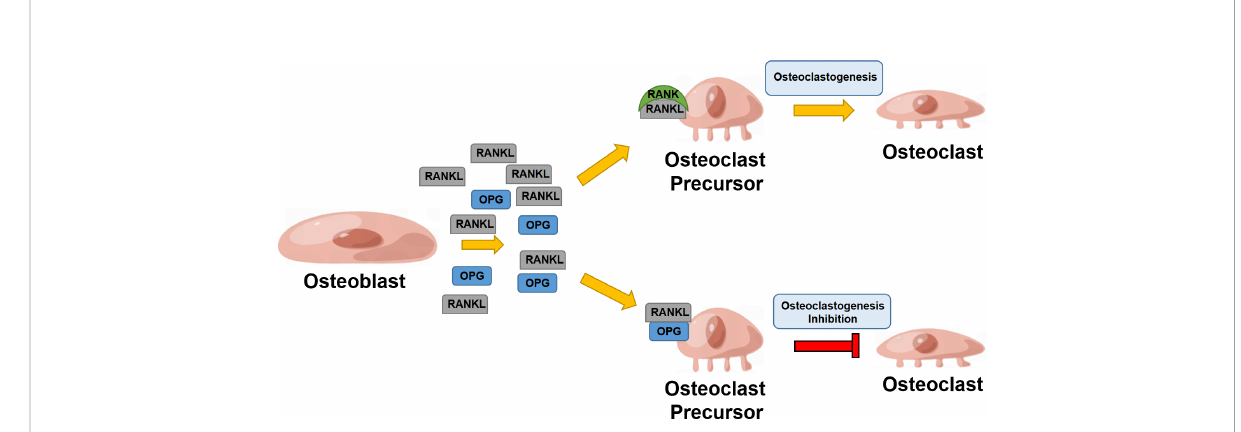
FIGURE 1 RANK/RANKL/OPG system in bone remodeling. Osteoblast secretes RANKL that binds to RANK, enhancing osteoclastogenesis; osteoblasts also secrete OPG, suppressing RANKL binding to RANK and inhibiting